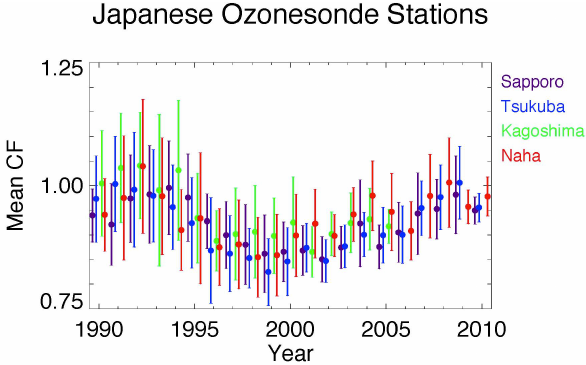
Fig. 5. Annual mean CFs for the data plotted in Fig. 4, with slight horizontal offsets for each station for clarity. The error bars repre- Figure 5. Annual mean CFs for the data plotted in Figure 4, with slight horizontal offsets 992 sent one standard for each station for clarity. The error bars represent one standard deviations. 993 994